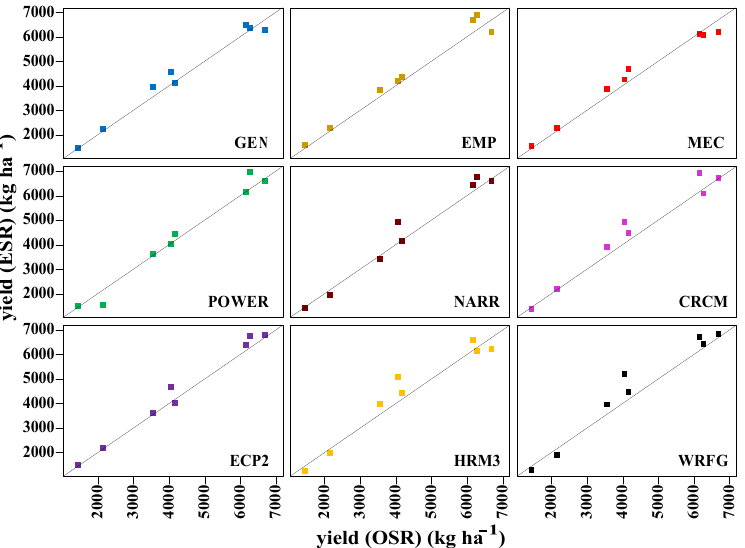
Figure 12. Maize yield (kg ha − 1 ) for the eight-year analysis period simulated using daily solar radiation observations and estimates as input to CERES − Maize. OSR and ESR refer to observed and estimated solar radiation, respectively. Note: the simulated yields for the empirical and the mechanistic models were combined for the calibration and validation periods.